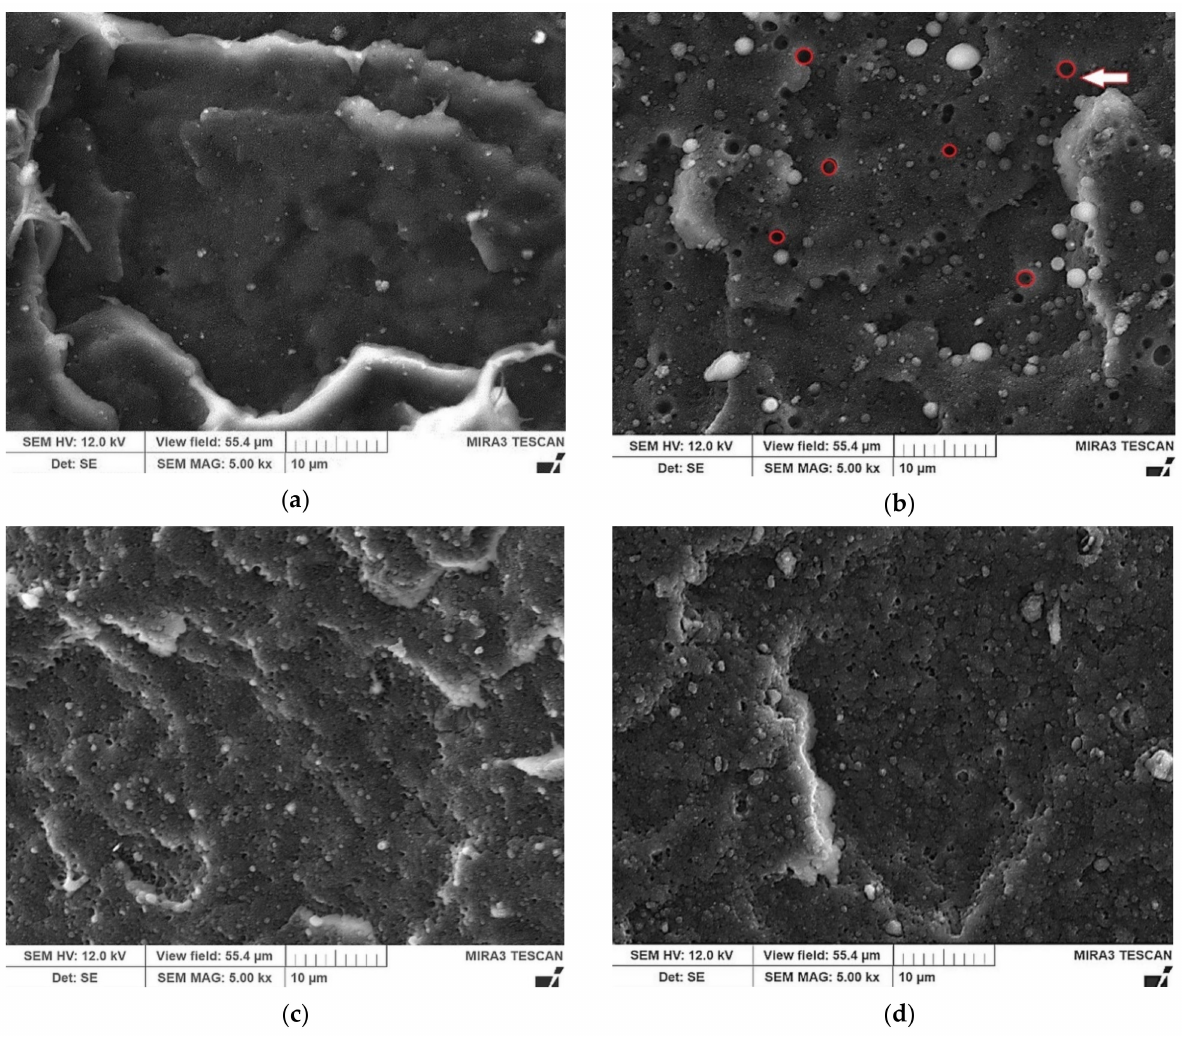
Figure 1. SEM micrographs of fractured surface of ( a ) R-PE and R-PE/R-PA ( b ) without and ( c ) with compatibilizer R-PE/R-PA/MAH1 and ( d ) R-PE/R-PA/MAH3; magnification 5000 ×